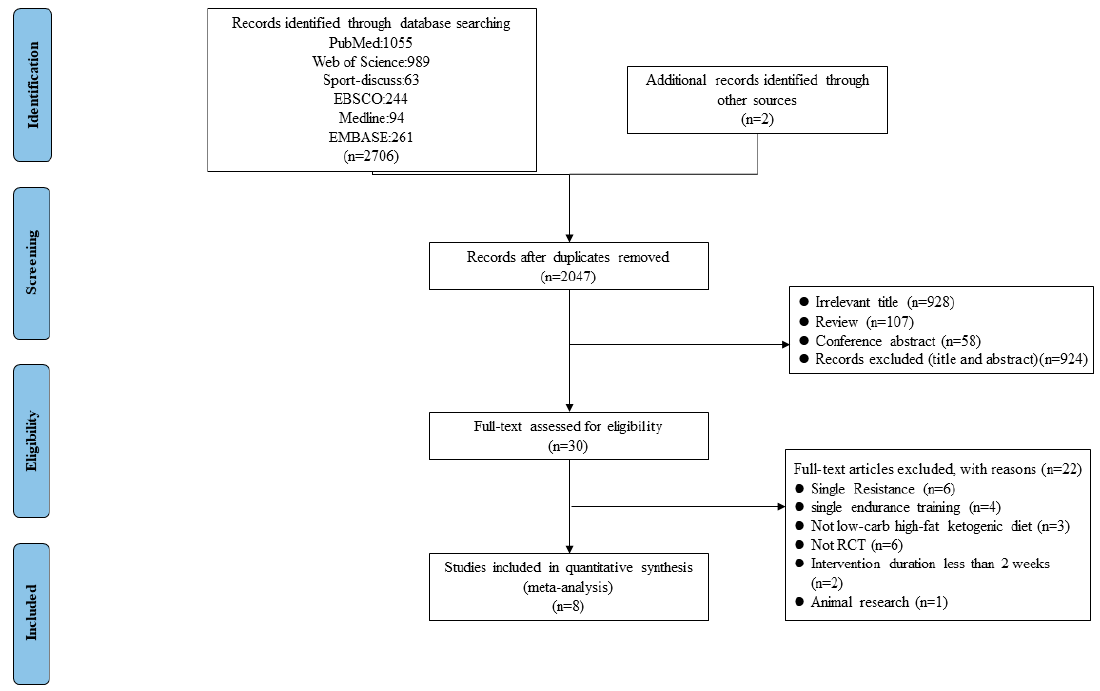
Figure 1. Flow chart for selection of studies.